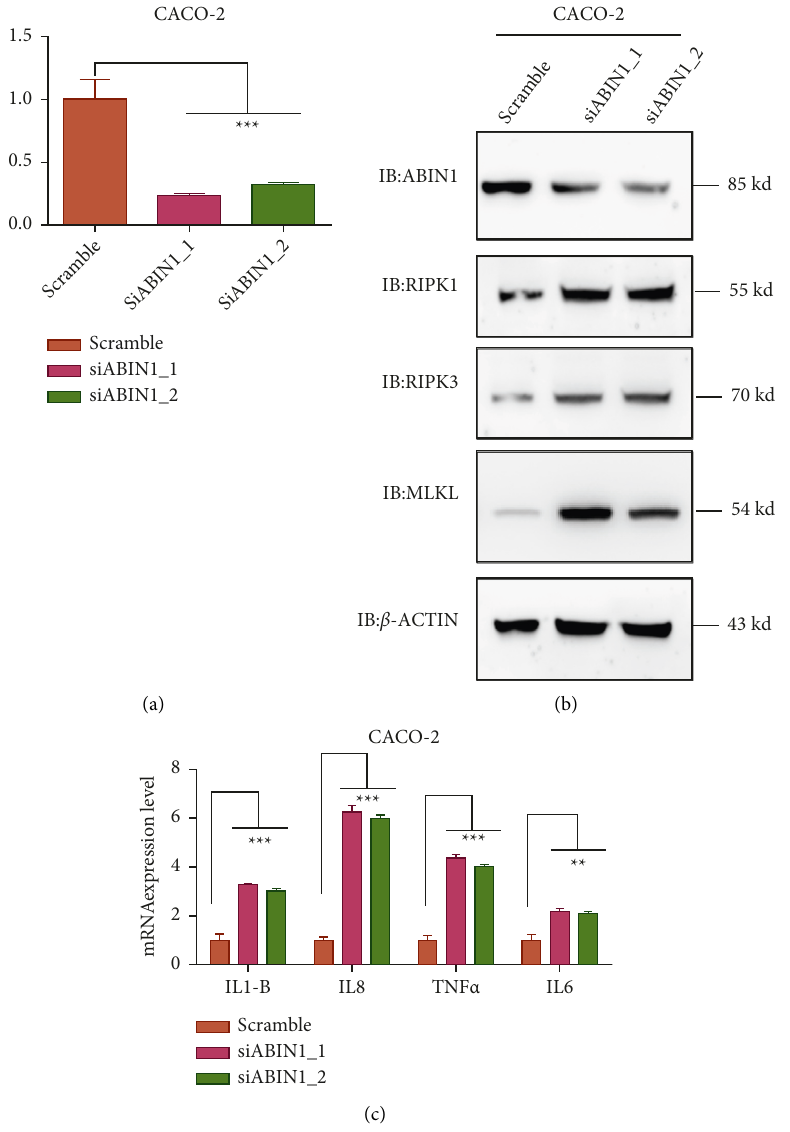
Figure 3: ABIN1 knockdown in IEC promotes necroptosis and the expression of proinflammatory cytokines in IEC. (a) mRNA expression level siRNA verification in CACO-2 cells; (b) Necroptosis-associated proteins detection in CACO-2 ABIN1 knock down stable upon TNF- α stimulation; and (c) ABIN1 knock down CACO-2 cells. Two-tailed Student’s t -test was performed to assess statistical significance. ∗∗ P < 0 . 01, ∗∗∗ P < 0 .